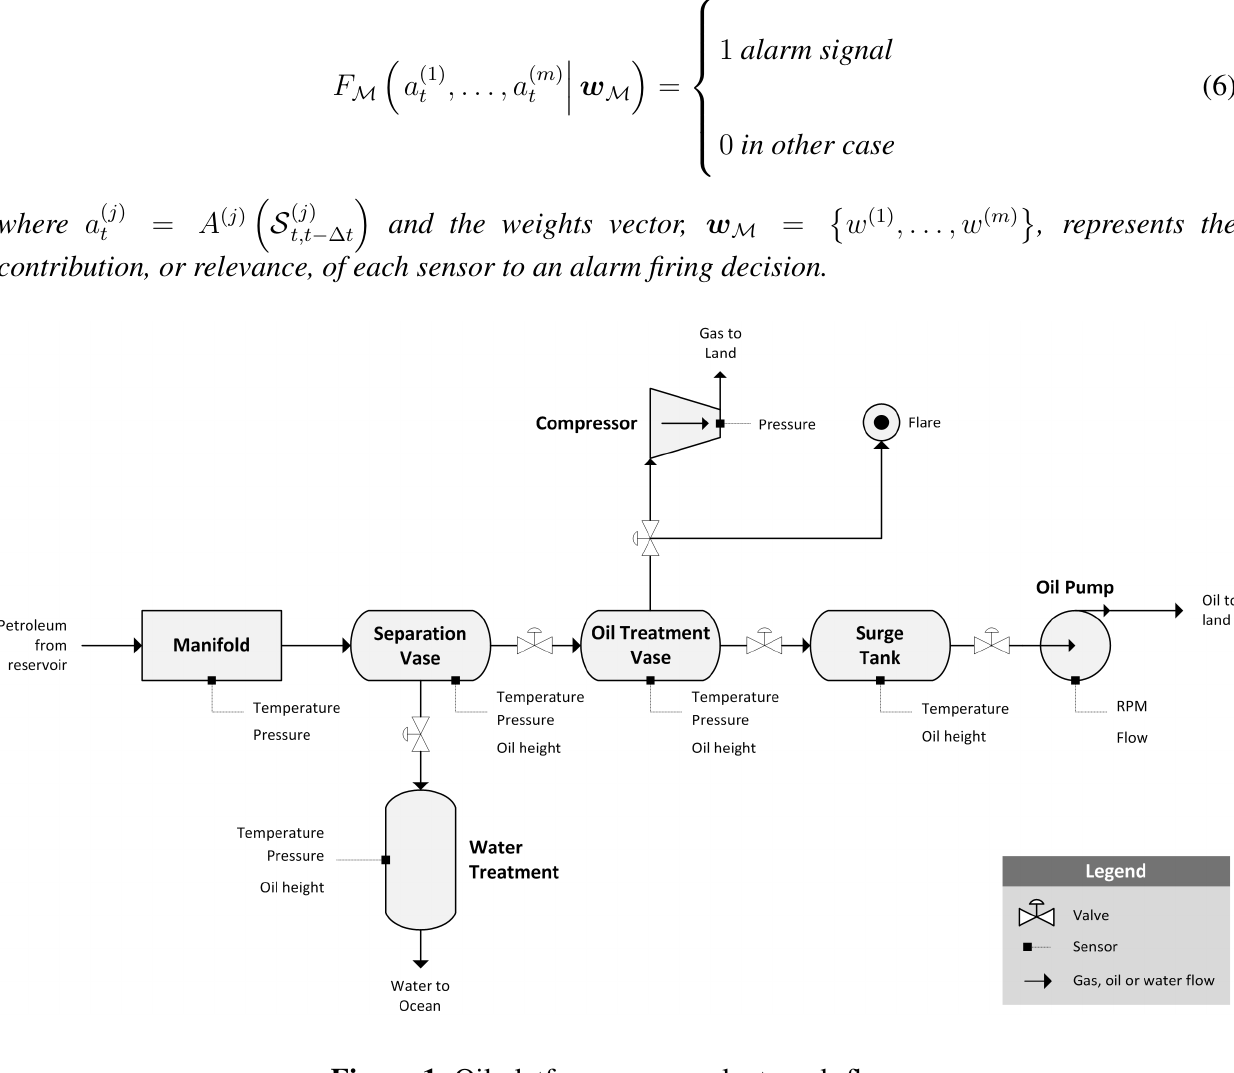
Figure 1. Oil platform process plant